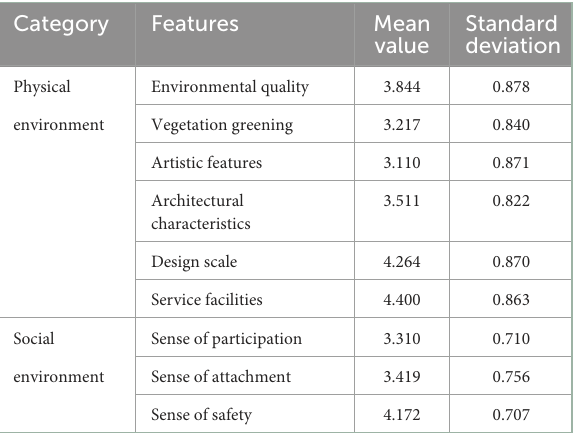
TABLE 2 Assessment scores of the physical and social environments of the urban residential